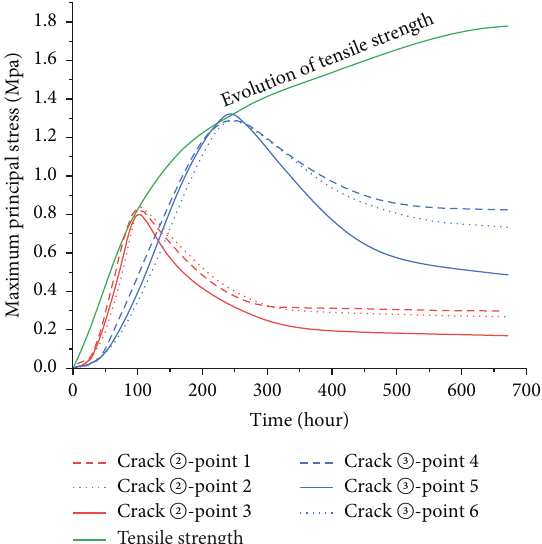
Figure 11: Tensile strength evolution against